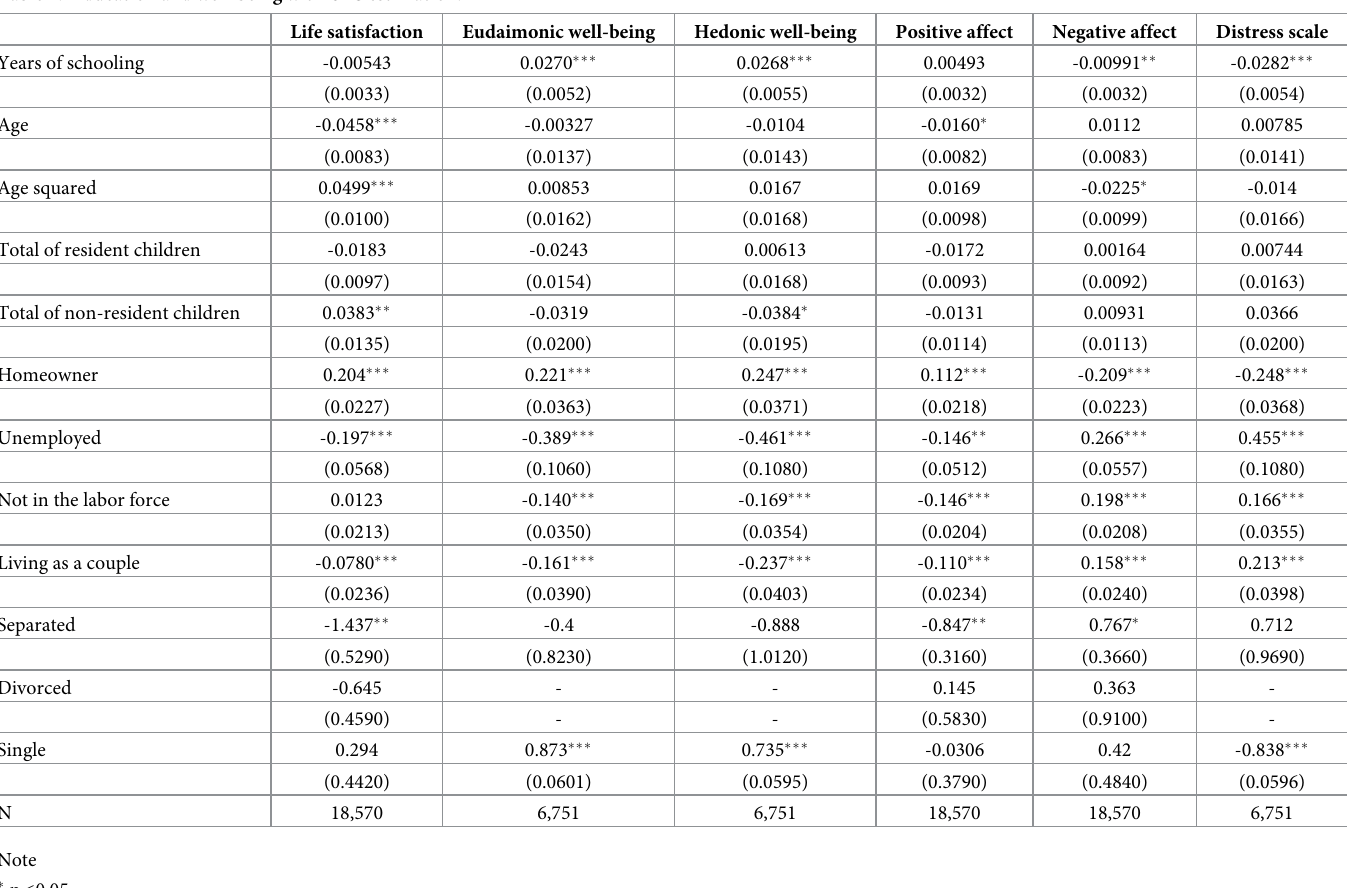
Table 2. Education and well-being with OLS